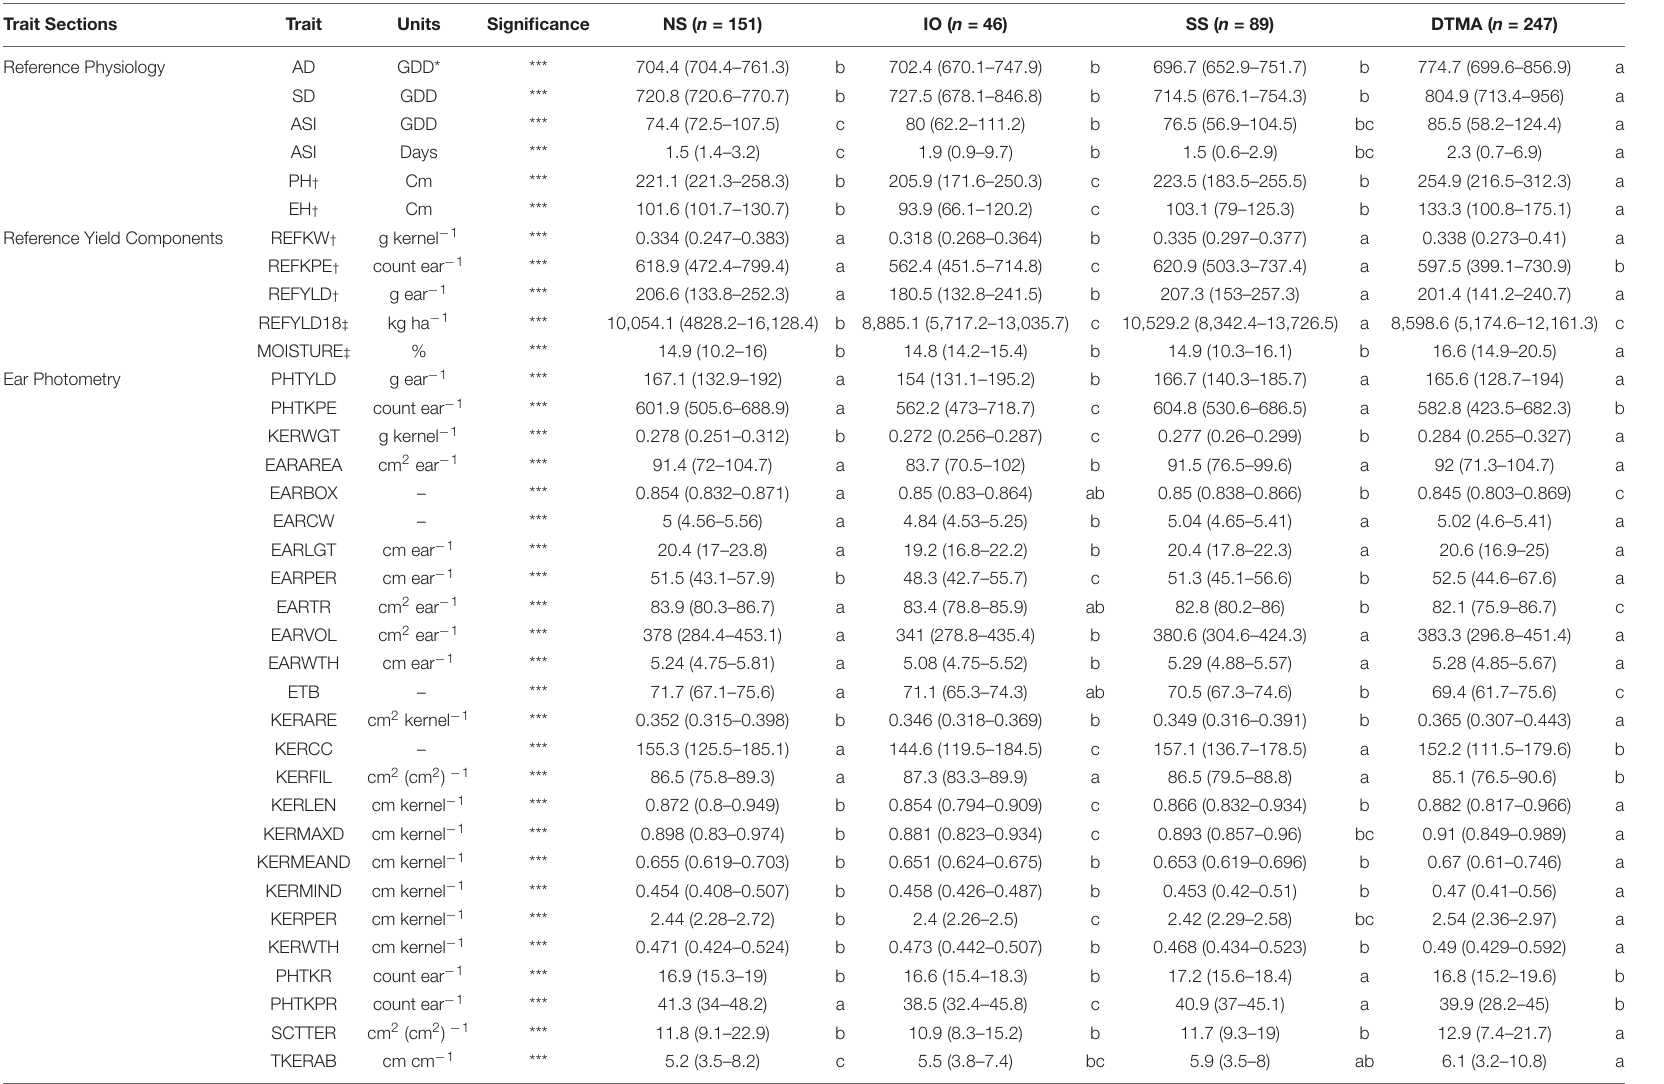
TABLE 3 | Best linear unbiased predictions (BLUPs) of all traits measured in this study for inbreds crossed to PHP02 based on heterotic group, NS (Non-Stiff Stalk), SS (Stiff Stalk), IO (Iodent), and DTMA (Drought Tolerant Maize for Africa). Trait